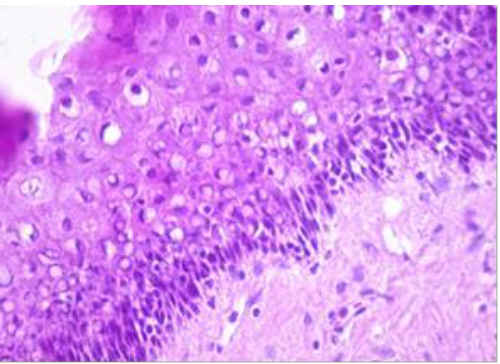
Figure 1. Exo-cervix showing a distinct basal layer and atypical keratinocytes (HE staining, 40 × ).